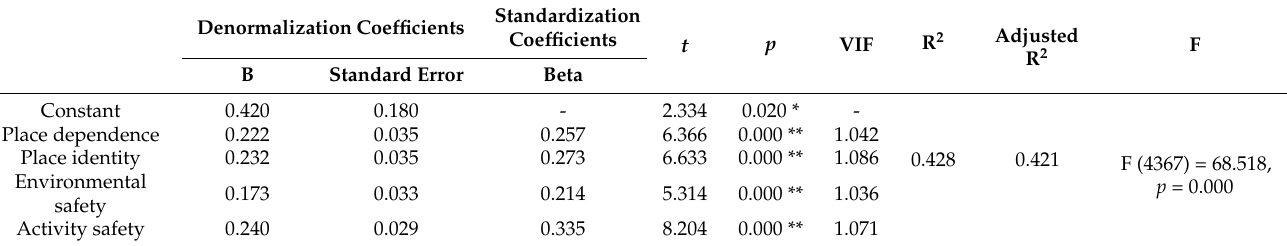
Table 9. Stepwise regression analysis